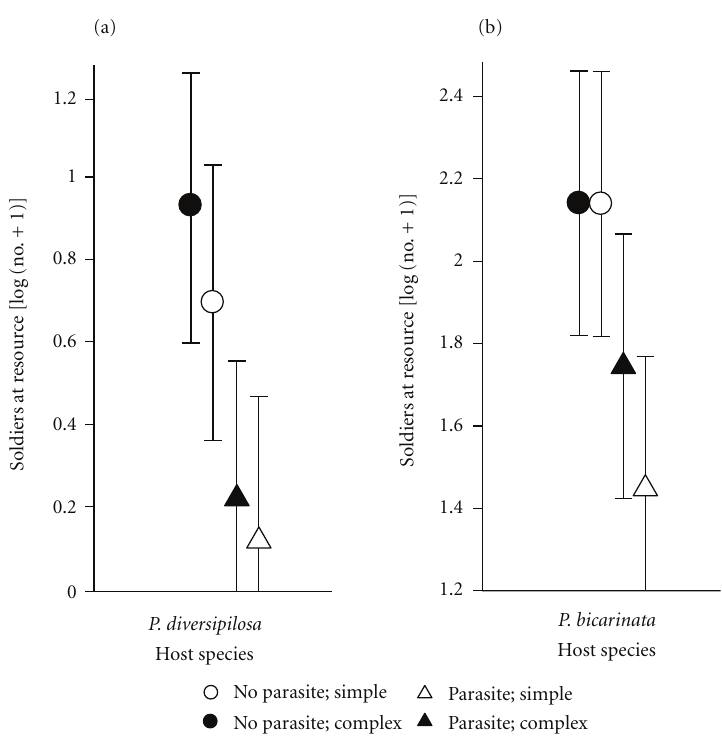
Figure 2: Number of (a) P. diversipilosa and (b) P. bicarinata soldiers harvesting resources in the absence of head-to-head competition when parasitoids are absent ( circles ) or present ( triangles ) in complex habitat ( filled symbols ) or simple habitat ( empty symbols ). Means and Tukey’s minimum significant di ff erence (MSD) comparison intervals are presented. Means whose comparison intervals overlap are not significantly di ff erent. Means whose comparison intervals do not overlap are significantly di ff erent at an experiment-wide α of